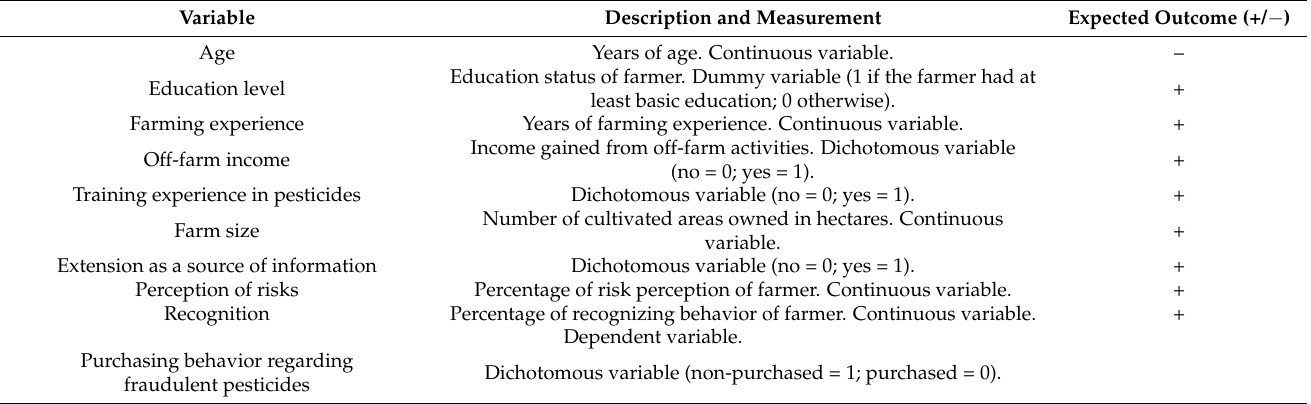
Table 1. Description and measurement of variables of the purchasing behavior